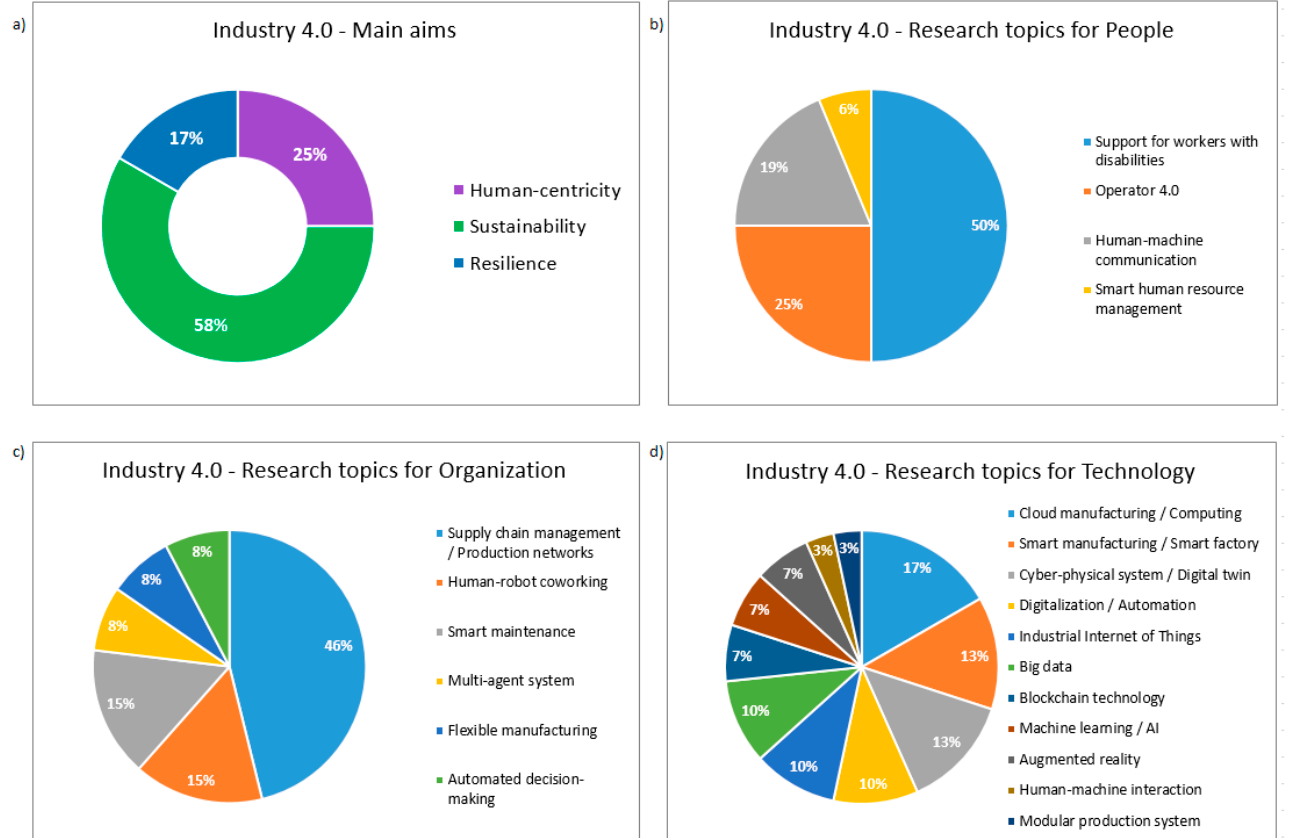
Figure 5. Industry 4.0 literature review: ( a ) Main research aims correlated to Industry 5.0 drivers; ( b ) research topics for Industry 4.0 and people; ( c ) research topics for Industry 4.0 and organization; ( d ) research topics for Industry 4.0 and technology.